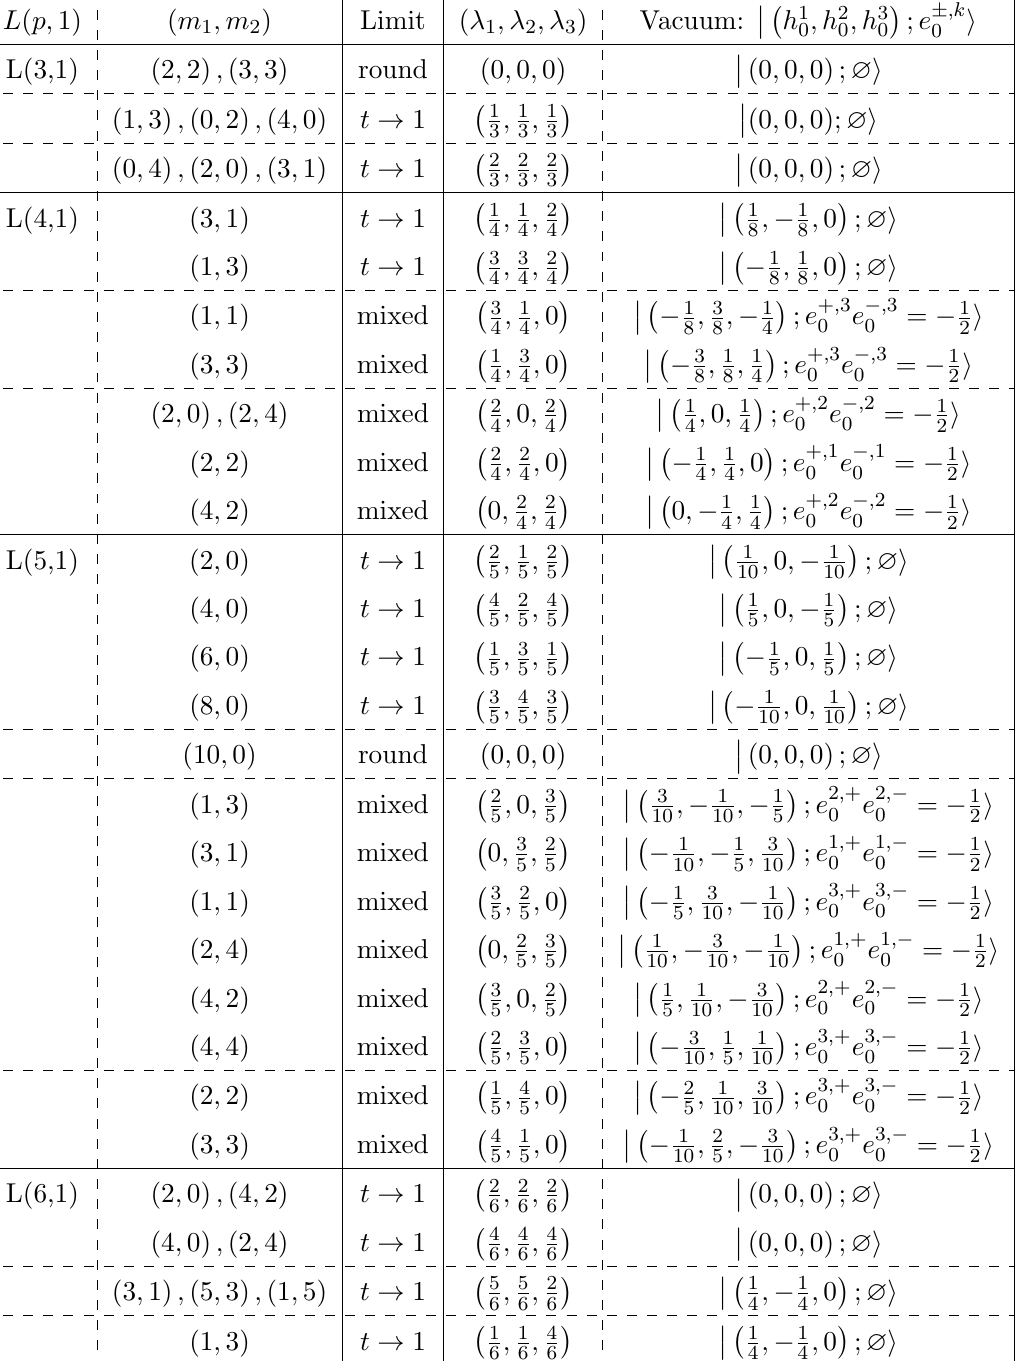
[ su (3) . The (cid:12)rst two (cid:0) 3 2